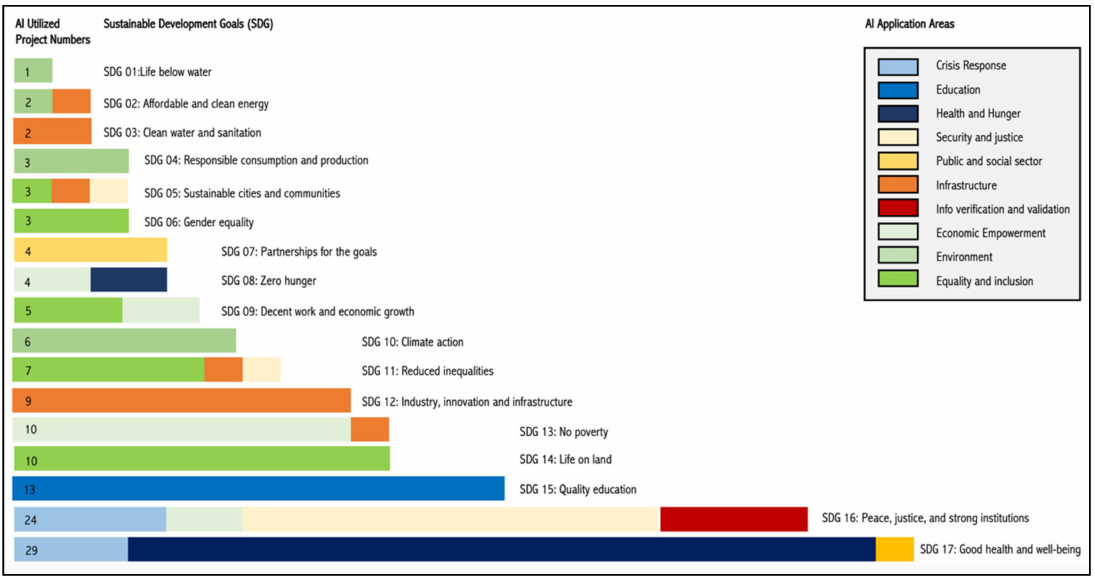
Figure 6. AI utilization for achieving sustainable development goals, derived from McKinsey Global Research Institute